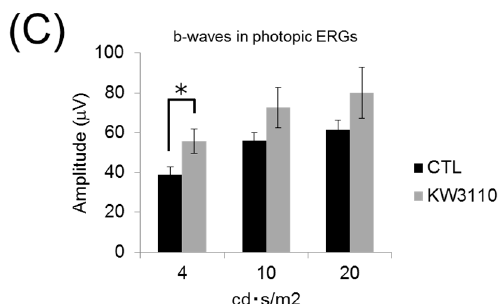
Figure 4. Suppression of visual function impairment by intake of L. paracasei KW3110. ( A ) The amplitude of a-waves in the scotopic ERG. ( B ) The amplitude of b-waves in the scotopic ERG. ( C ) The amplitude of b-waves in the photopic ERG. Results are represented as the mean ± SEM. * p < 0.05 for the control. CTL, control diet; KW3110, L. paracasei KW3110 diet.